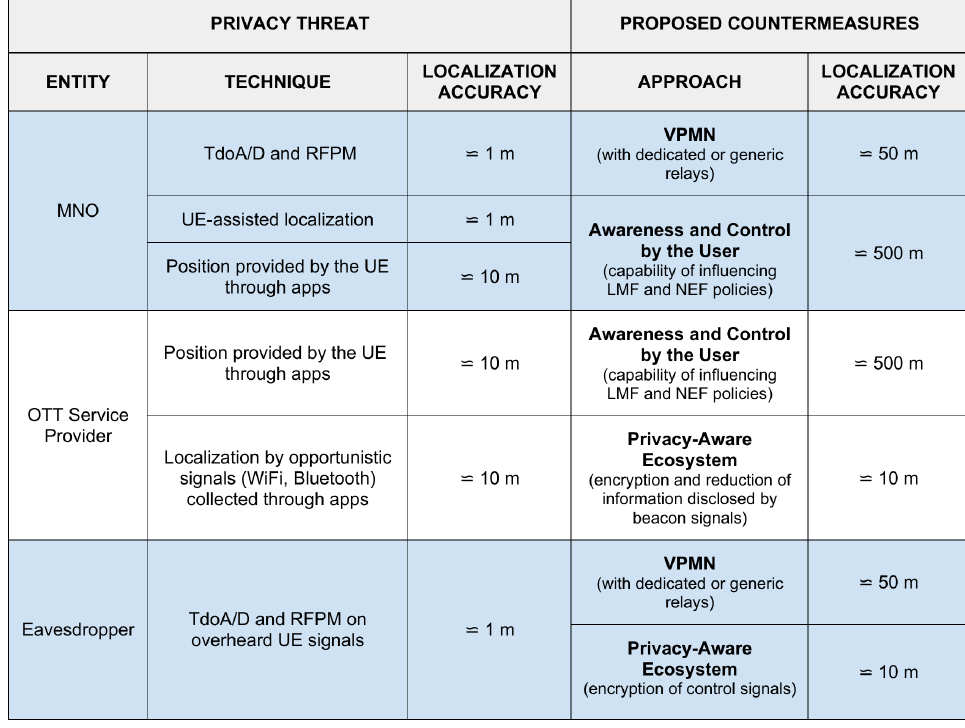
Figure 4. Location-privacy threats and